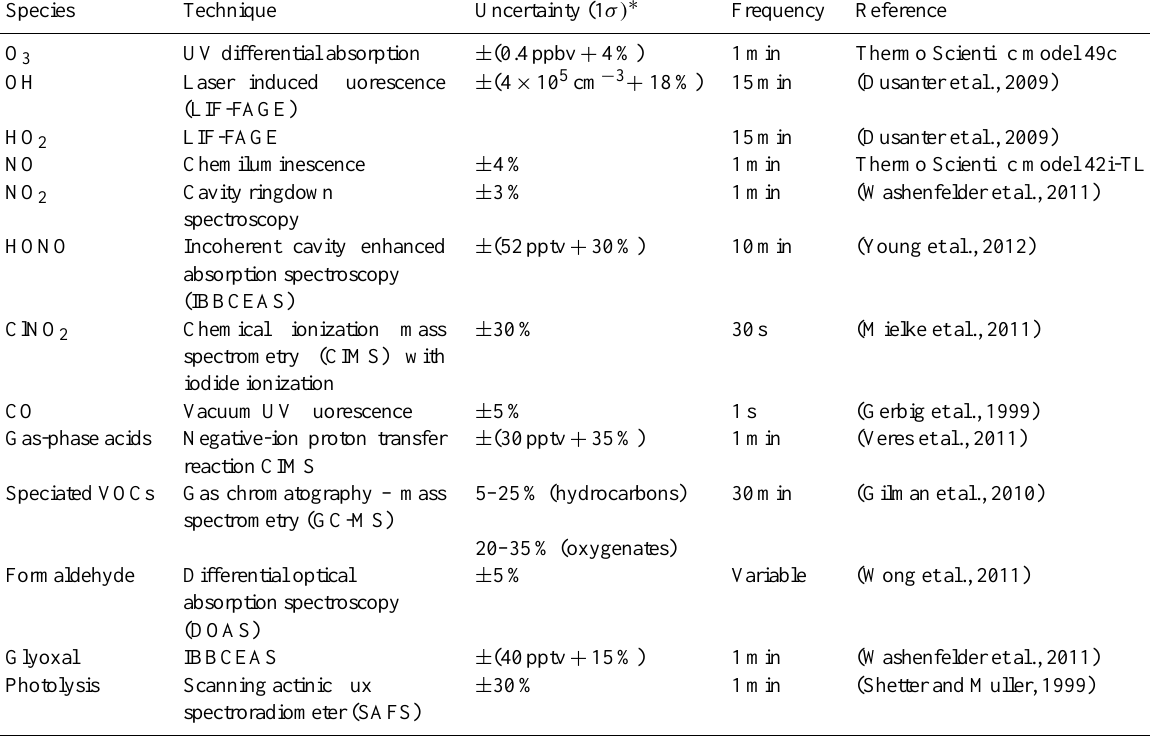
Table 1. Relevant measurements acquired during CalNex